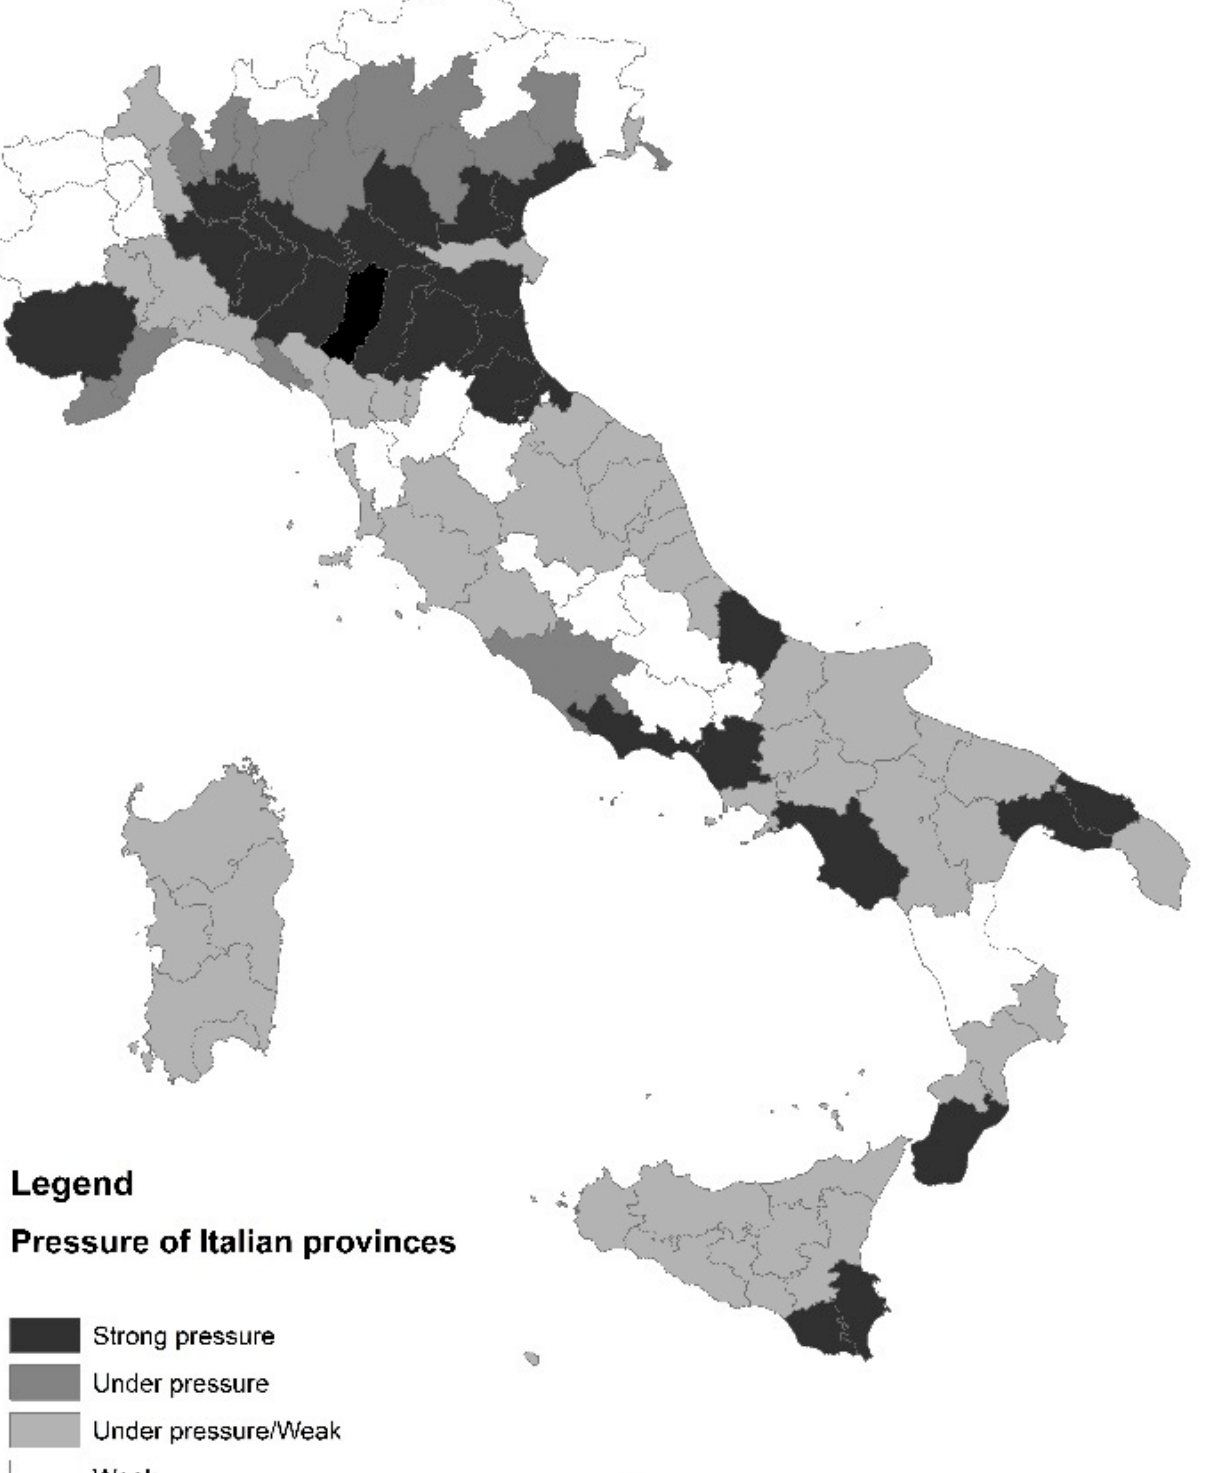
Figure 5. The representation of Italy by applying the Boscacci method (2). Territorial classification of each province that exists in Italy. Source: Boscacci, 2010.